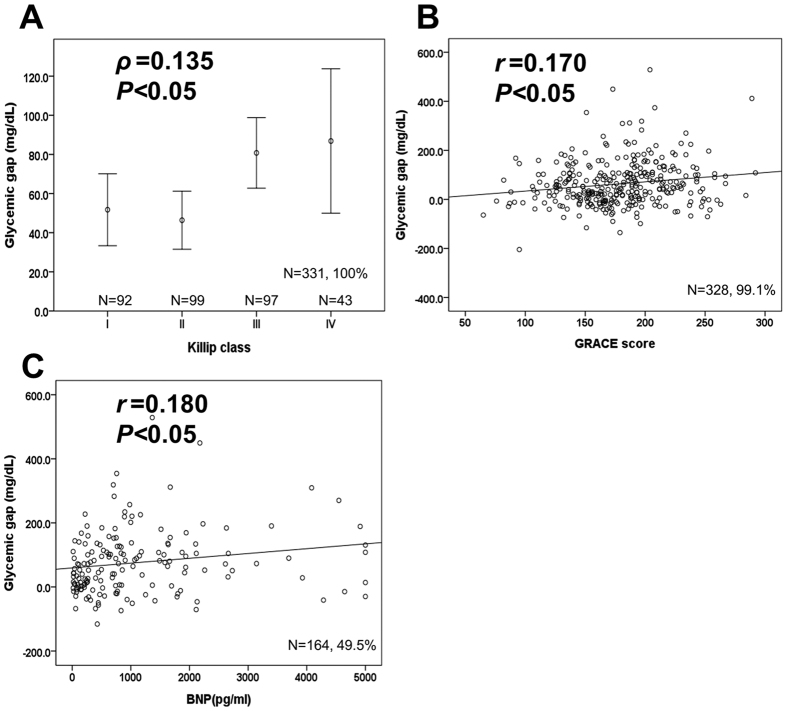
Correlations between glycemic gaps and Killip classification, GRACE scores and BNP levels.